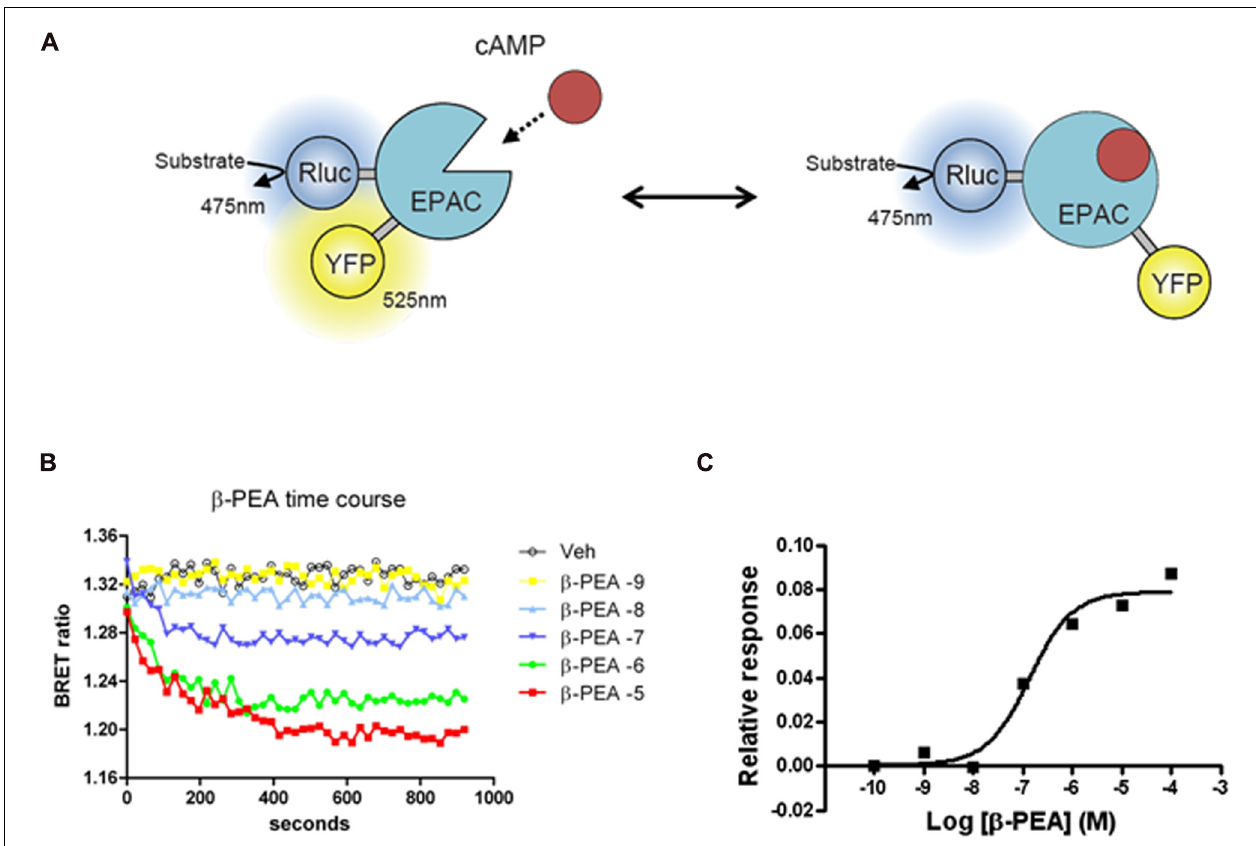
FIGURE 2 | Bioluminescence resonance energy transfer (BRET) EPAC biosensor for cAMP monitoring. (A) Cartoon of the postulated molecular rearrangement of the full-length EPAC protein with and without intracellular cAMP increase causing related BRET signal. EPAC, a protein that changes conformation upon cAMP binding, was tagged with a BRET donor (Rluc) and a BRET acceptor (YFP) on each extremity of the protein to monitor intramolecular BRET signal. (B) Time course effects β -PEA in cells transiently